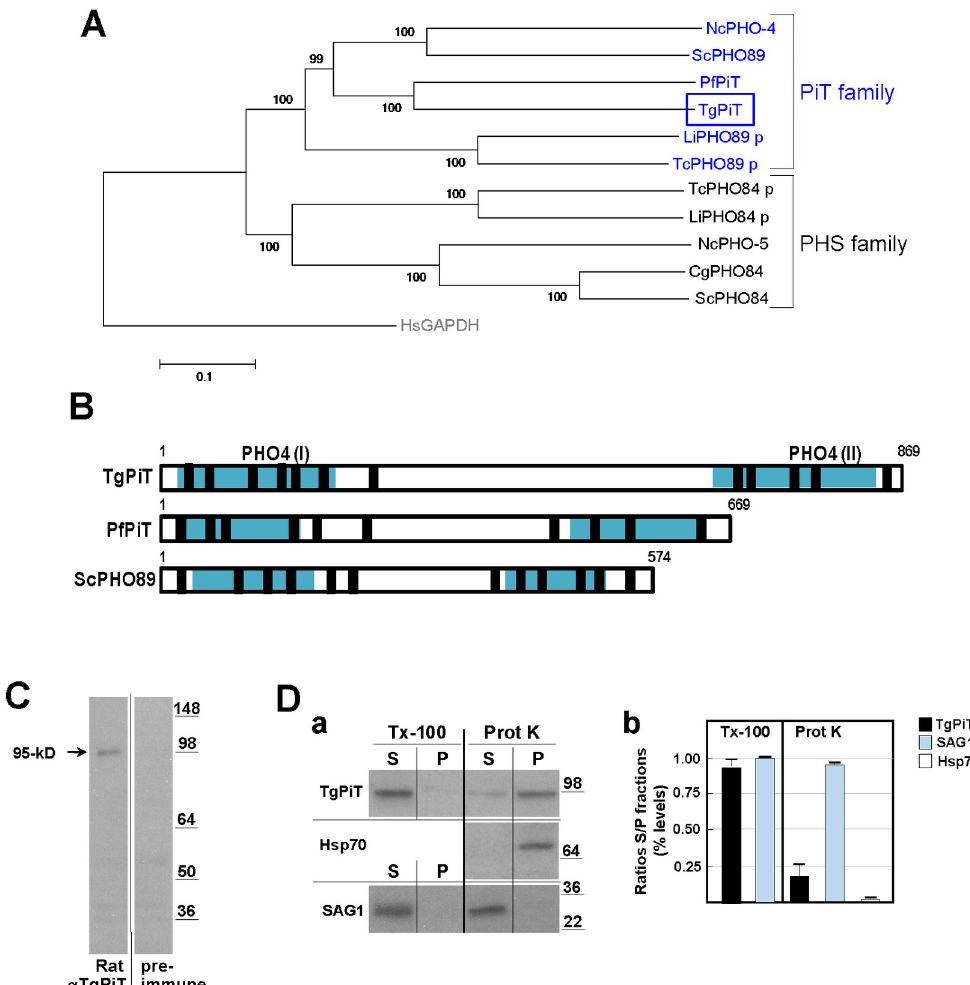
Fig 2. Motif features and expression of TgPiT in Toxoplasma . A. Phylogenetic analysis of the PHS and PiT family proteins. Amino acid sequences from different unicellular eukaryotic species were aligned and phylogenetic analysis was performed using MEGA 5.2.2 software. The PiT family members include PHO-4 from Neurospora crassa (GenBank: AAA33607.1), ScPHO89 from Saccharomyces cerevisiae (GenBank: NP_009855.1), PfPiT from Plasmodium falciparum (GenBank: CAE30463.1), LiPHO89 p from Leishmania infantum (GenBank: XP_001466587.1) and TcPHO89 p from Trypanosoma cruzi (GenBank: XP_813912.1), The PHS family members include TcPHO84 p from T . cruzi (GenBank: XM_809326.1), LiPHO84 p from L . infantum (GenBank:AFJ96967.1), NcPHO-5 from N . crassa (GenBank: AAA74899.1), CgPHO84 from Candida glabrata (GenBank: XM_445078.1) and ScPHO84 from S . cerevisiae (GenBank: CAA89157.1). p = putative sequence based on functional motif identifications. Outgroup: HsGAPDH from Homo sapiens (GenBank: NP_002037.2). B. Conserved domains in TgPiT. TgPiT has two conserved PHO4 domains (I and II) containing GLU residues required for P i translocation (turquoise boxes), present in the PiT of yeast (ScPHO89) and P . falciparum (PfPiT; MAL13P1.206). TgPiT contains 12 putative TMD (black boxes) and a large intracellular loop at between TMD 7 and 8. C. Expression of TgPiT. Immunoblots of Toxoplasma lysates (10E7 parasites per lane) were incubated with anti-TgPiT antibodies showing a band at ~95 kD. D. Biochemical analysis of TgPiT in isolated parasites. Solubilization of TgPiT: after washing, parasites isolated from cells were lysed in buffer containing 1% TritonX-100 (Tx-100) for 15 min before centrifugation of the lysate and collection of the supernatant (S; detergent-solubilized fraction) and pellet (P; membrane fraction) for SDS-PAGE and Western blotting using antibodies against TgPiT or the surface protein SAG1 as positive control (panel a). Surface-exposure of TgPiT: after washing, extracellular Toxoplasma were incubated 30 min in the presence of 0.1 mg/ml of proteinase K (Prot K) or reaction buffer alone at 22˚C before adding PMSF to inactivate proteinase K, centrifugation to collect the supernatant (S; Proteinase K-sensitive fraction) and the pellet (P; Proteinase K- resistant fraction) for SDS-PAGE and Western blotting using antibodies against TgPiT, SAG1 (plasma membrane) and Hsp70 (cytosol) antibodies as controls for surface-proteolysis (panel a). Panel b shows the quantification of the ECL signal on immunoblots from 3 independent assays (means ± SD) and expressed in percent of ratios of S fractions to P fractions for TritonX-100 or proteinase K